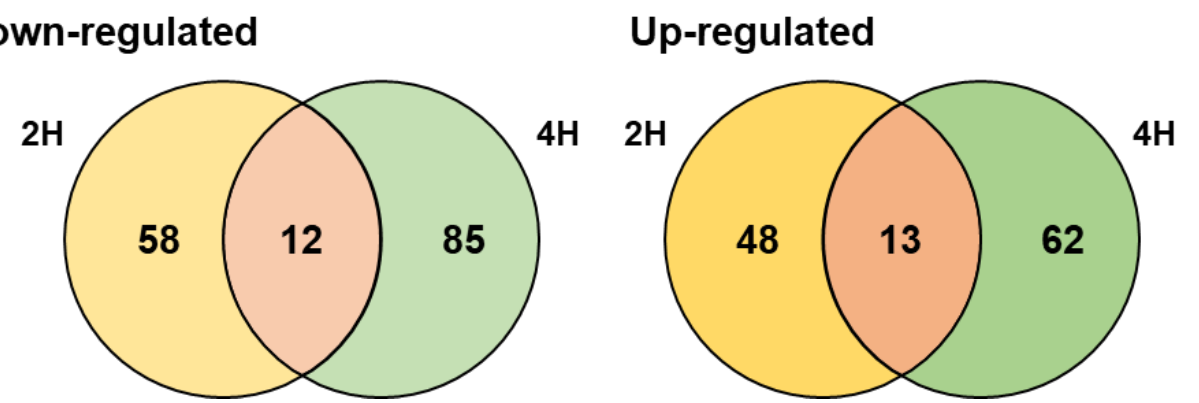
Figure 3. Venn diagram of DEGs in strain KM1031 under 7% NaCl stress for 2 and 4 h. Overlapping regions represent shared genes between different salt-exposure times [2 h (2H) and 4 h (4H)]. The numbers outside the overlapping regions indicate the numbers of significantly differentially expressed genes that were not common to the two conditions.